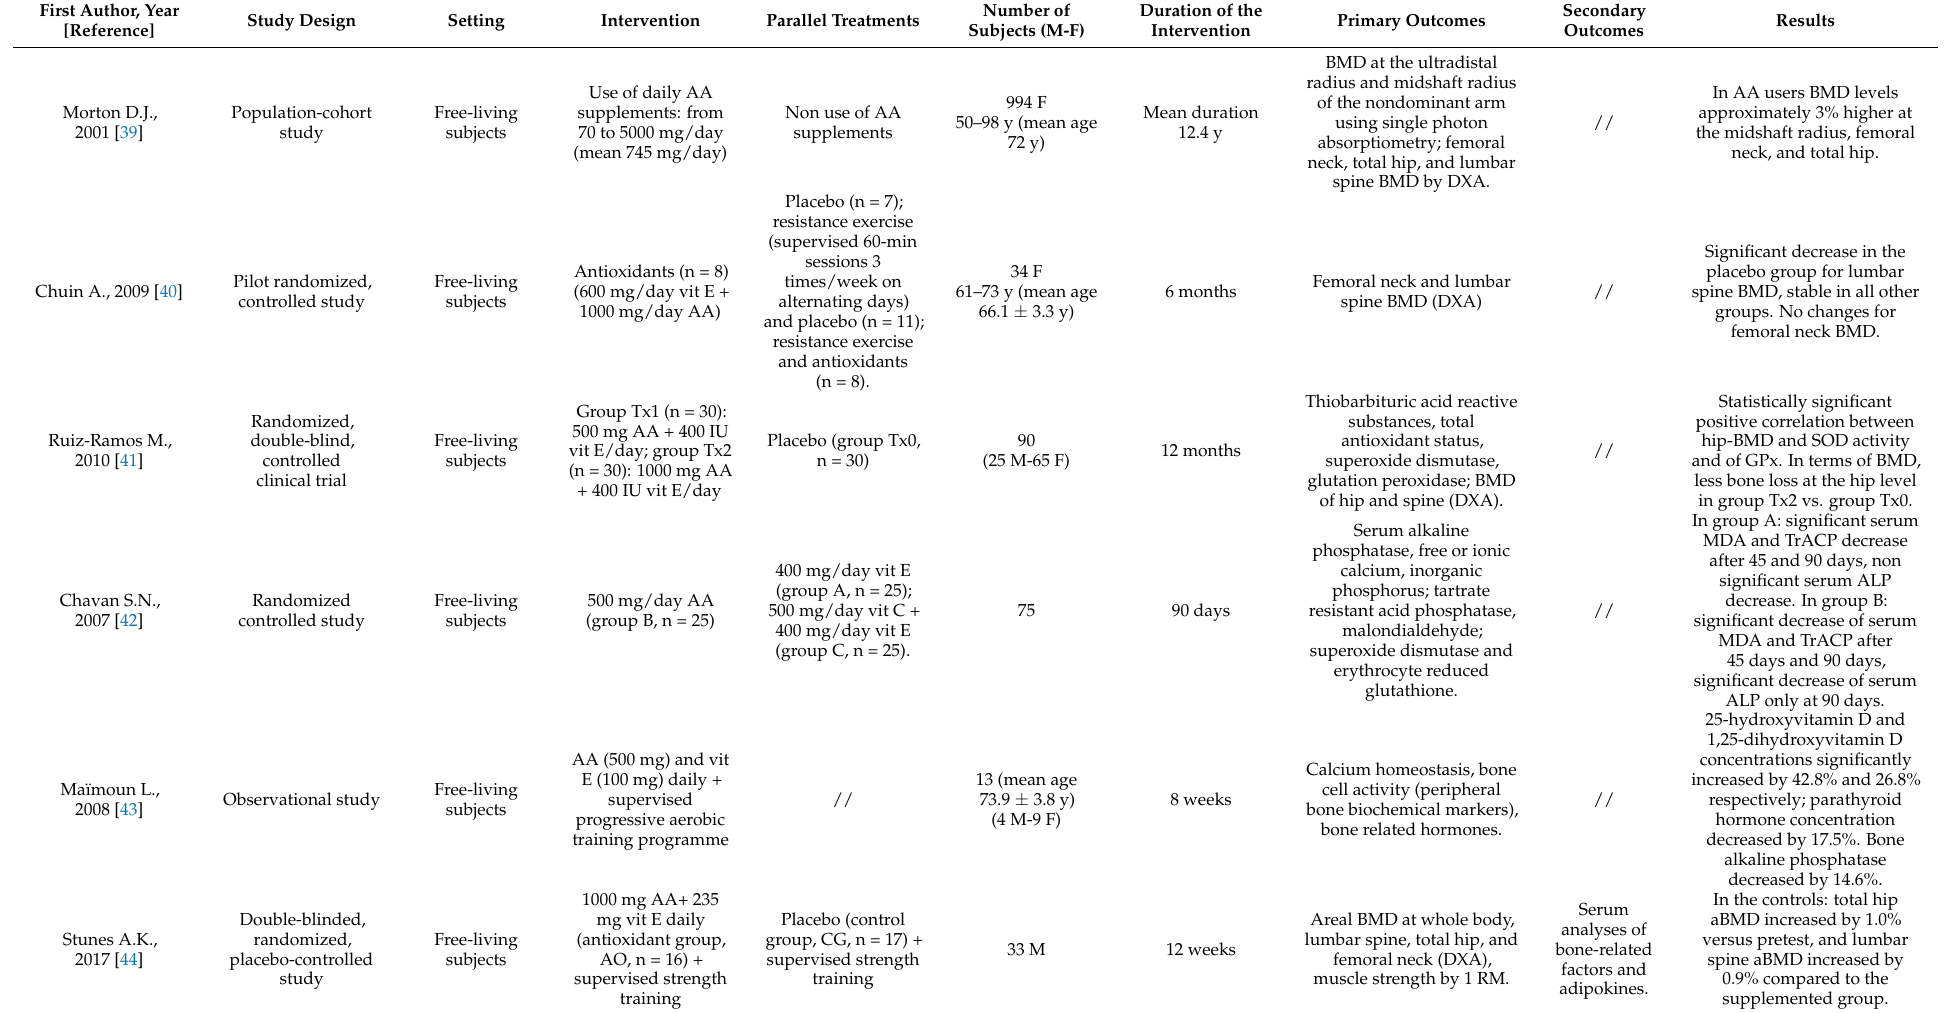
Table 4. Studies that considered AA